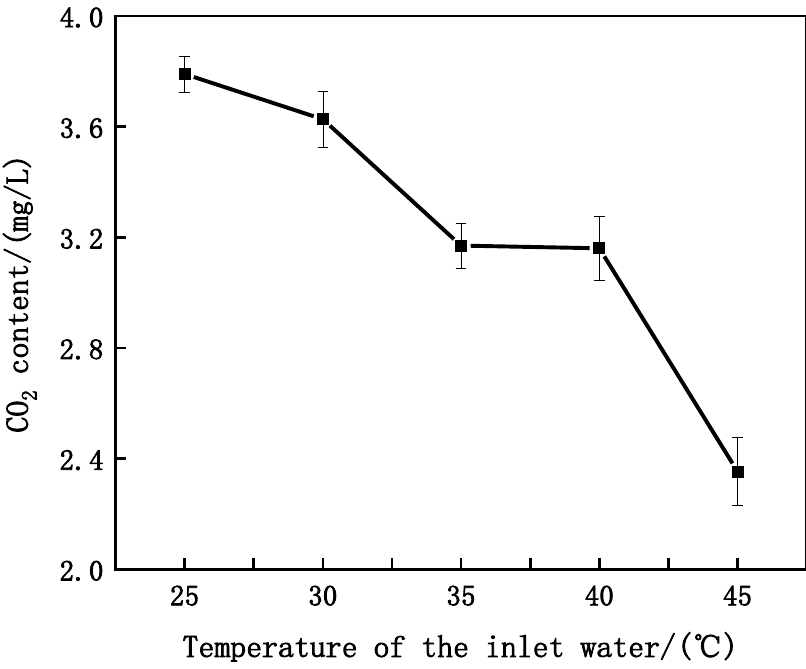
Figure 4. Line chart of the CO 2 content variation at different temperatures.